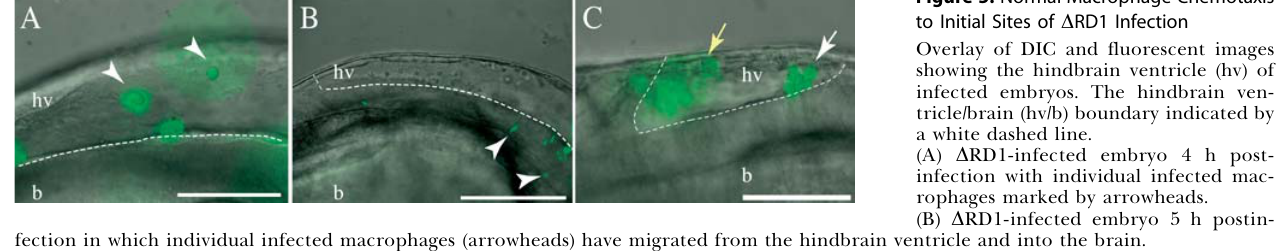
fection in which individual infected macrophages (arrowheads) have migrated from the hindbrain ventricle and into the brain. (C) WT-infected embryo 24 h postinfection with macrophages beginning to aggregate (white arrow) in the hindbrain ventricle. A second out-of- focus aggregate is to the left (yellow arrow). Scale bar, 100 l m.